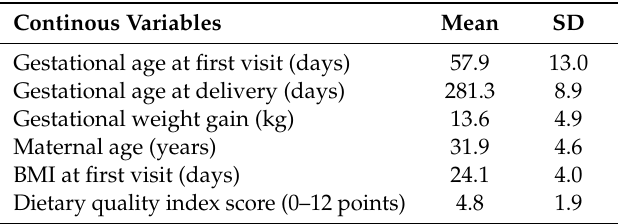
Table 1. Characteristics of the 1113 pregnant women from the GraviD